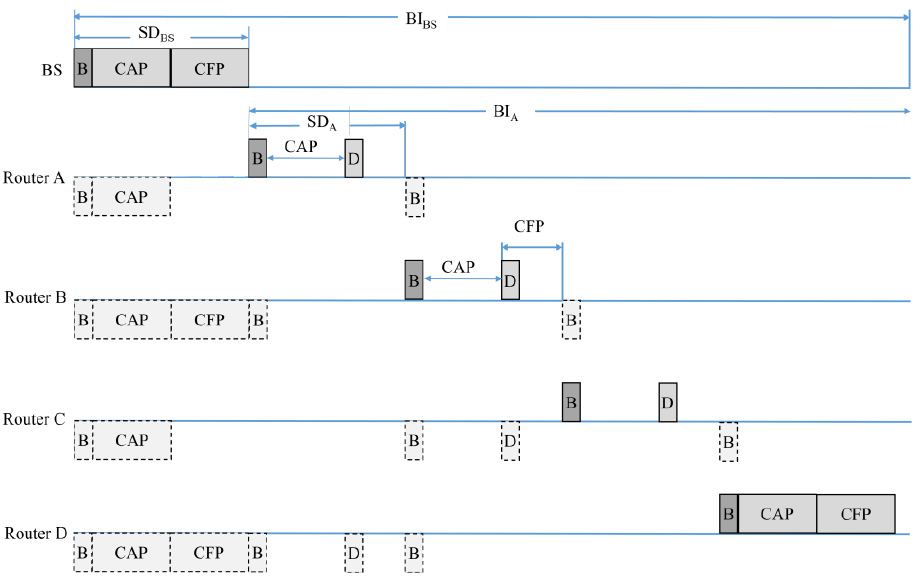
Figure 10. Data flow of the mesh network configured using the TSMR.